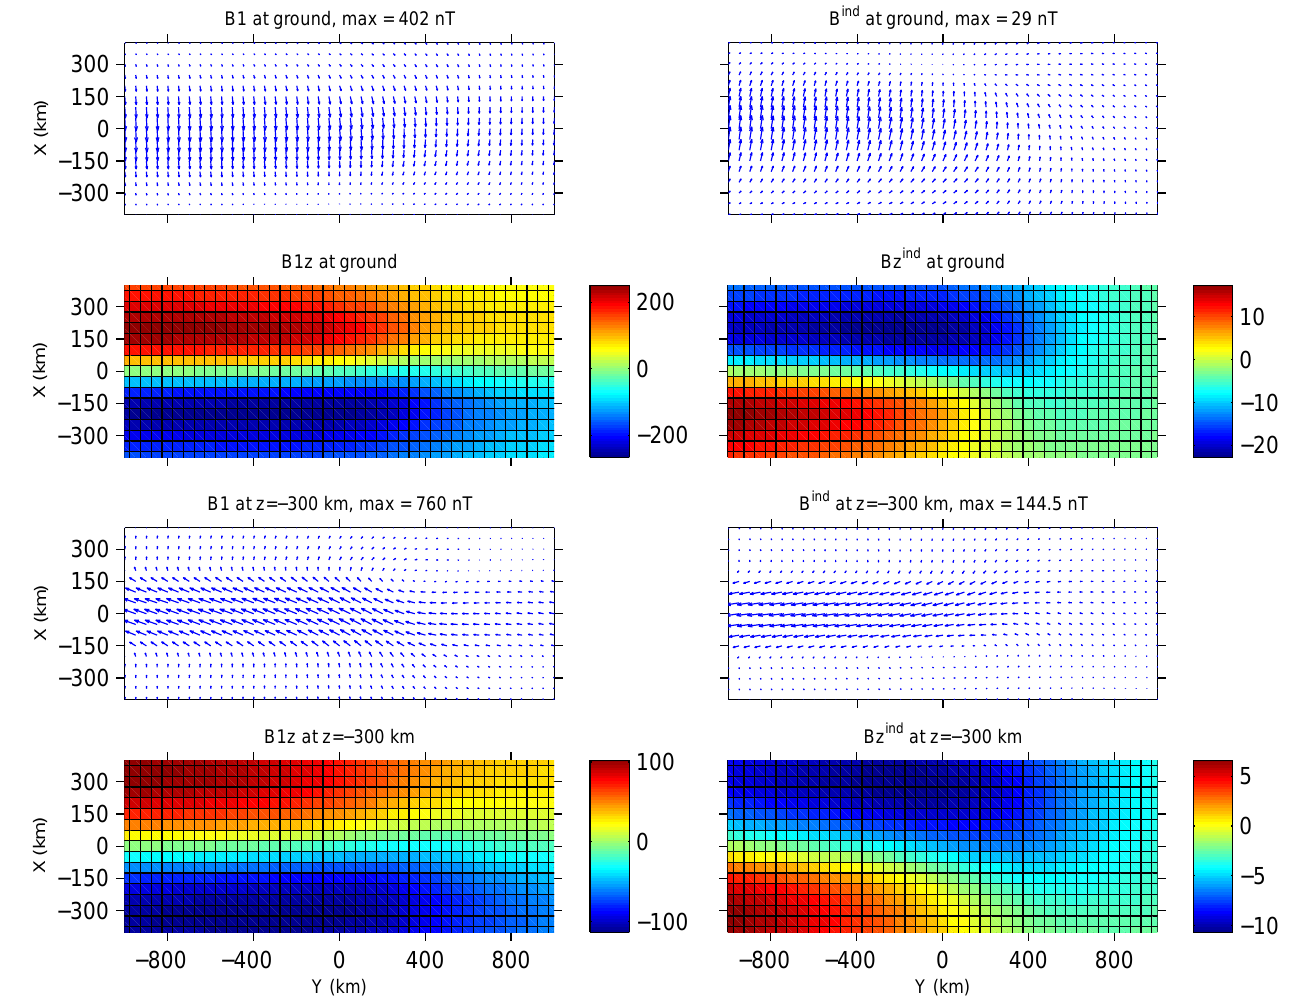
Fig. 7. The magnetic fields associated with the input ( B 1 ) and induced ( B ind ) electrojet system at the ground and at 300km above the ionospheric current layer at time instant t = 40s.